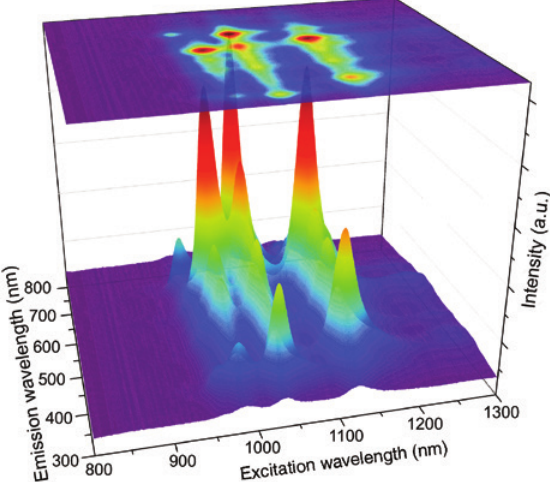
Figure 10: Example of photoluminescence map of the SWNT- polymer solution. The map clearly shows the presence of SWNT with geometries: (6,5); (7,3); (7,5); (7,6); (8,3); (8,4); (8,7); (9,2); (9,4); (10,3).